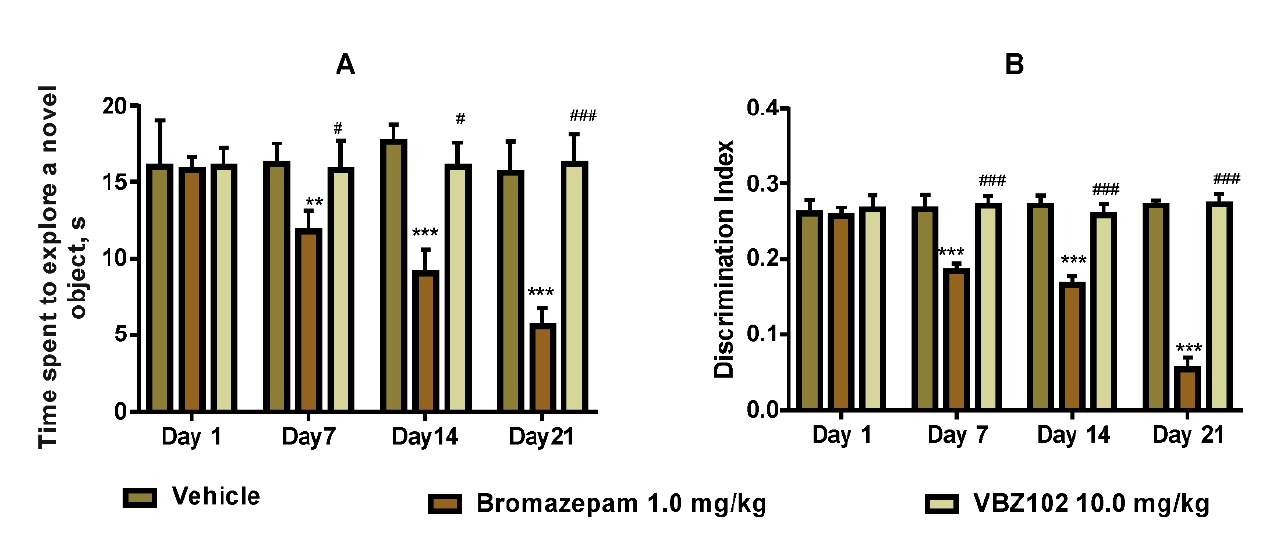
Figure 5. Novel object recognition test. ( A ) Time spent by different groups of mice to explore the novel object. ( B ) Discrimination index performance of different groups of mice. The data are expressed as mean ± standard deviation. The analysis was done using two-way repeated-measures analysis of variance followed by the Tukey post-hoc test. *** p ≤ 0.001, ** p ≤ 0.01, compared to the vehicle group, ### p ≤ 0.001, ## p ≤ 0.01, # p ≤ 0.05, compared to the bromazepam group.